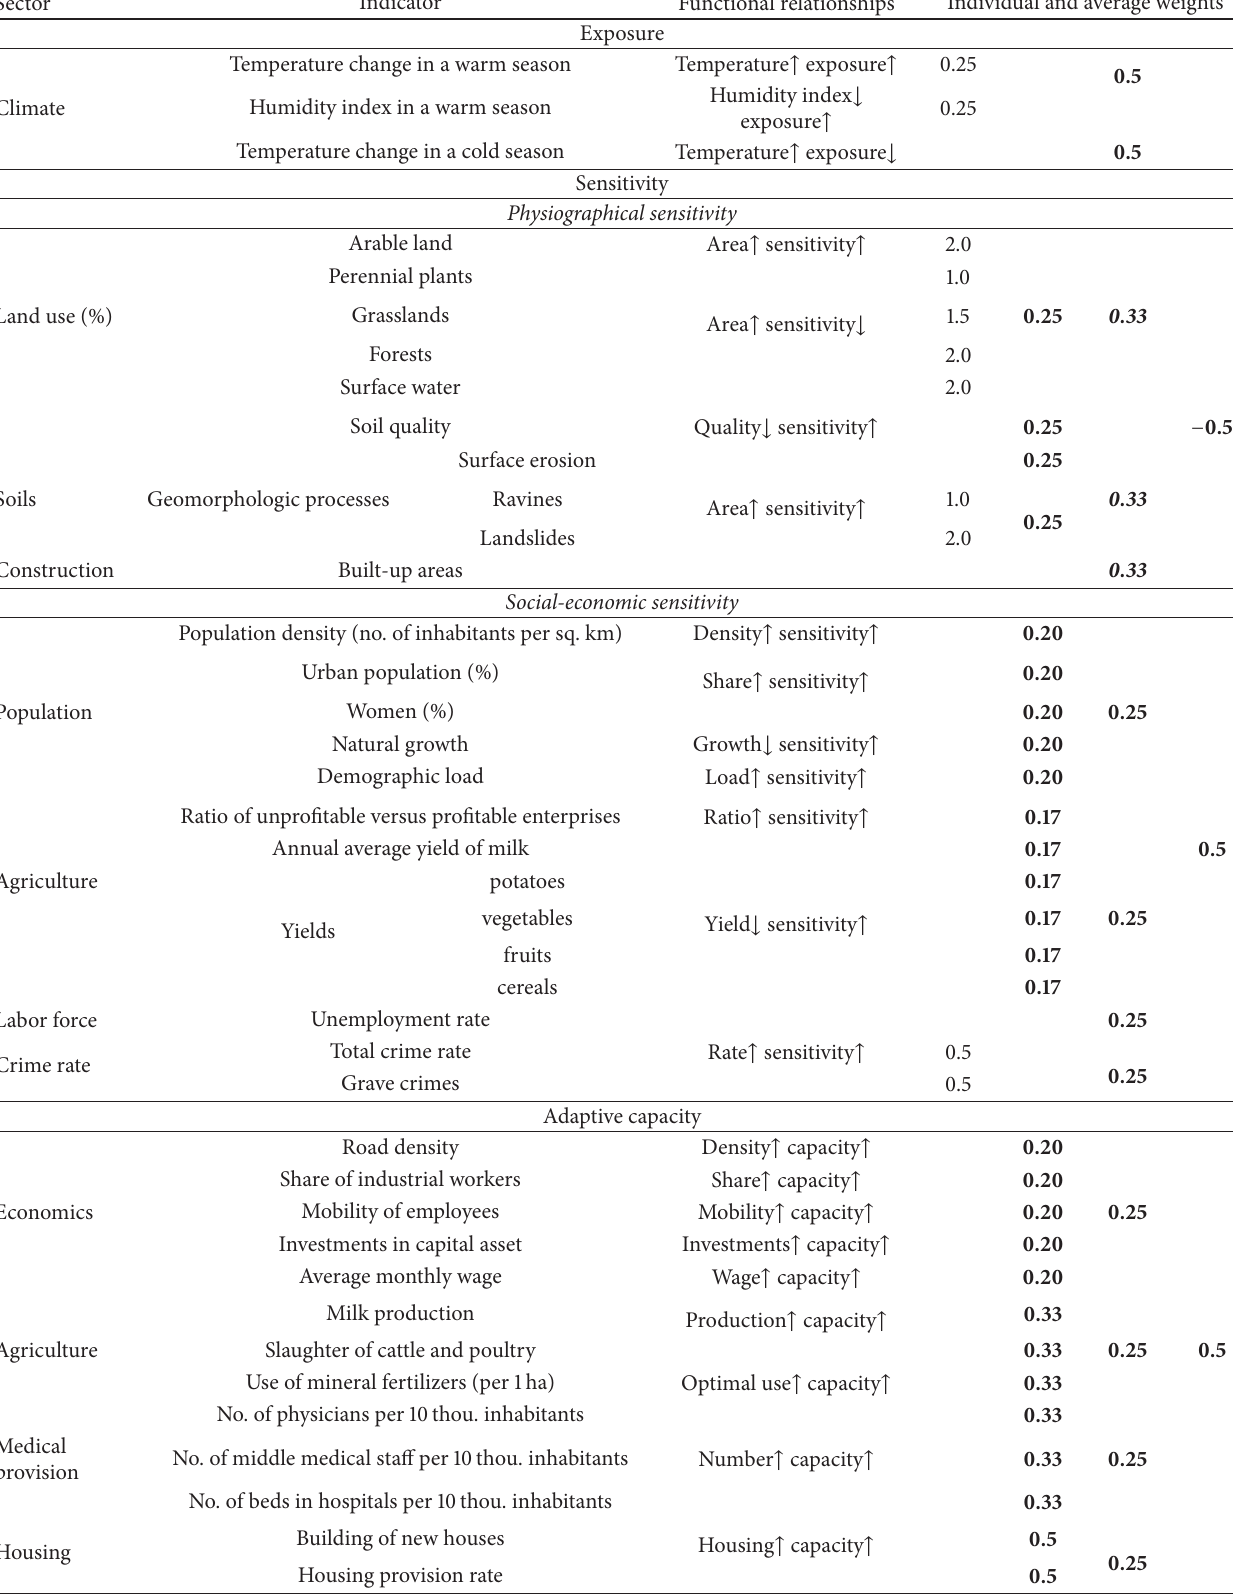
Table 1: Evaluation scheme of the assessment of vulnerability to climate